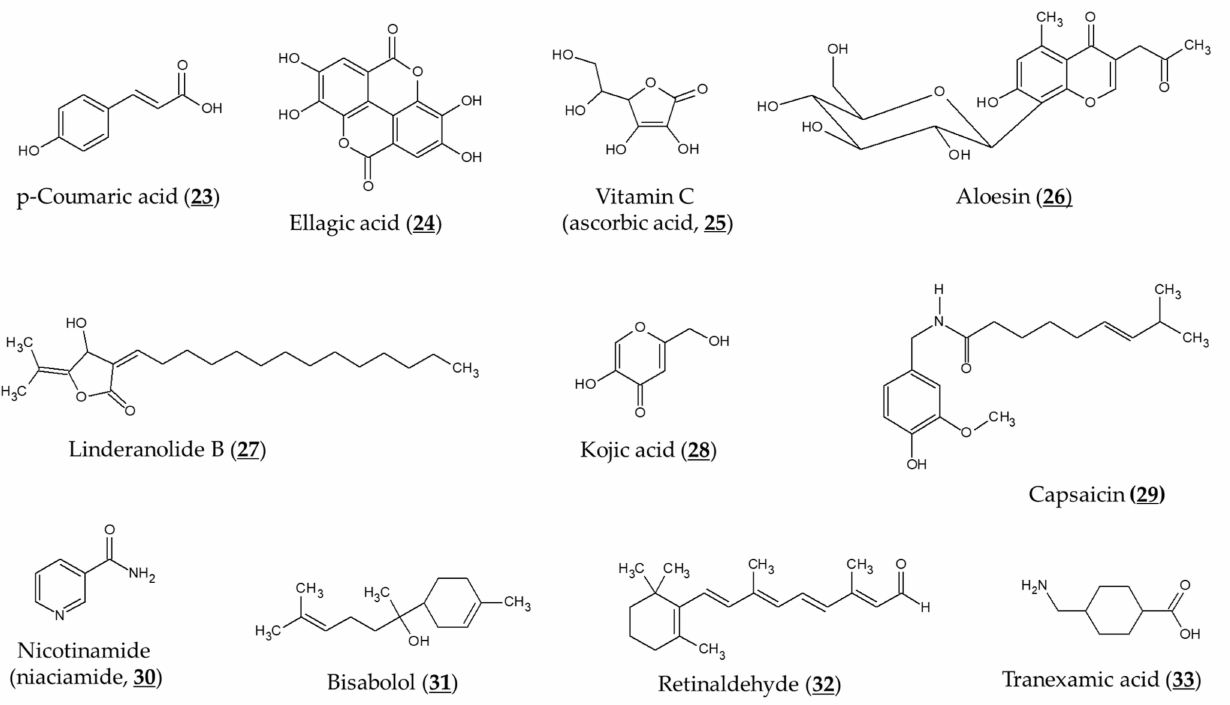
Figure 5. Chemical structures of various compounds that can affect the depigmenting activity of arbutin. Most compounds can additively or synergistically enhance the activity of arbutin, whereas capsaicin antagonizes the activity of